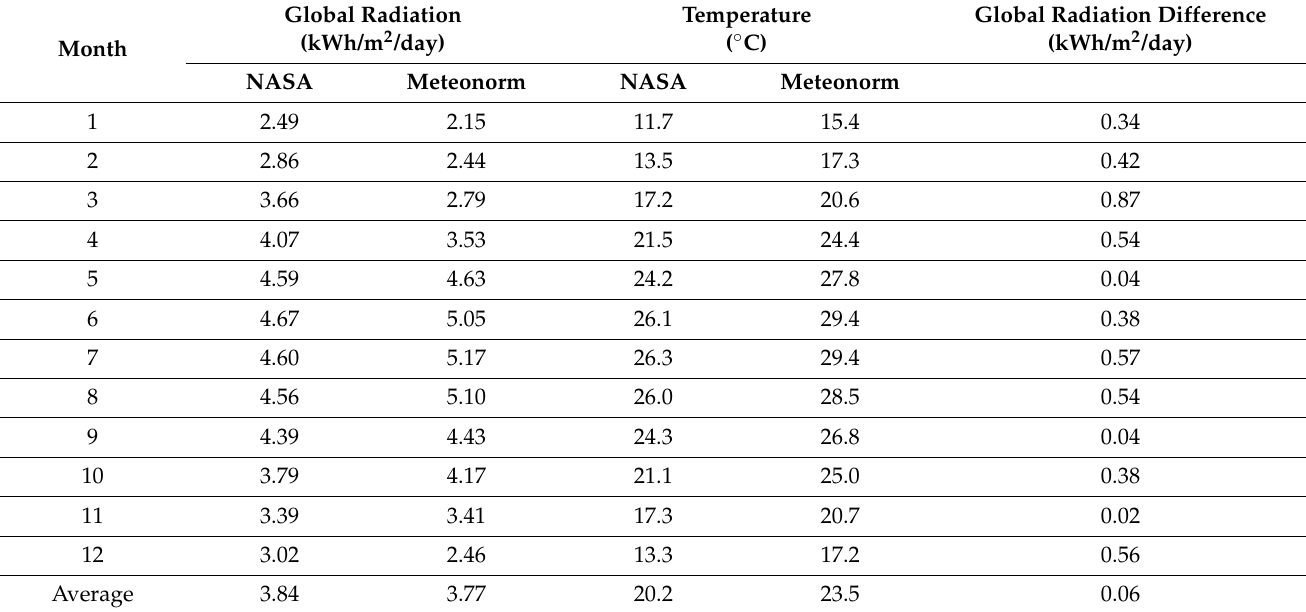
Table 1. Weather data of NASA and